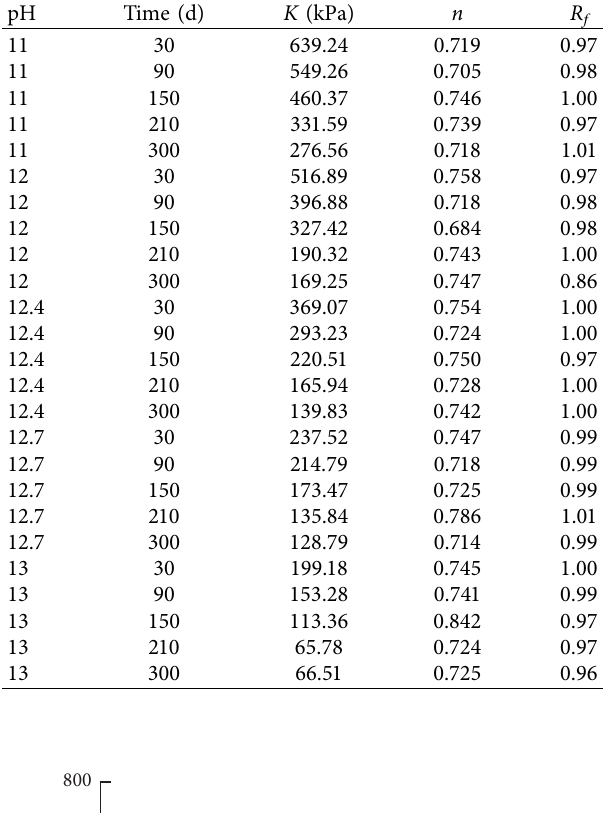
Table 2: K , n , and R f values of laterite at different alkaline-solution concentrations and permeation times.